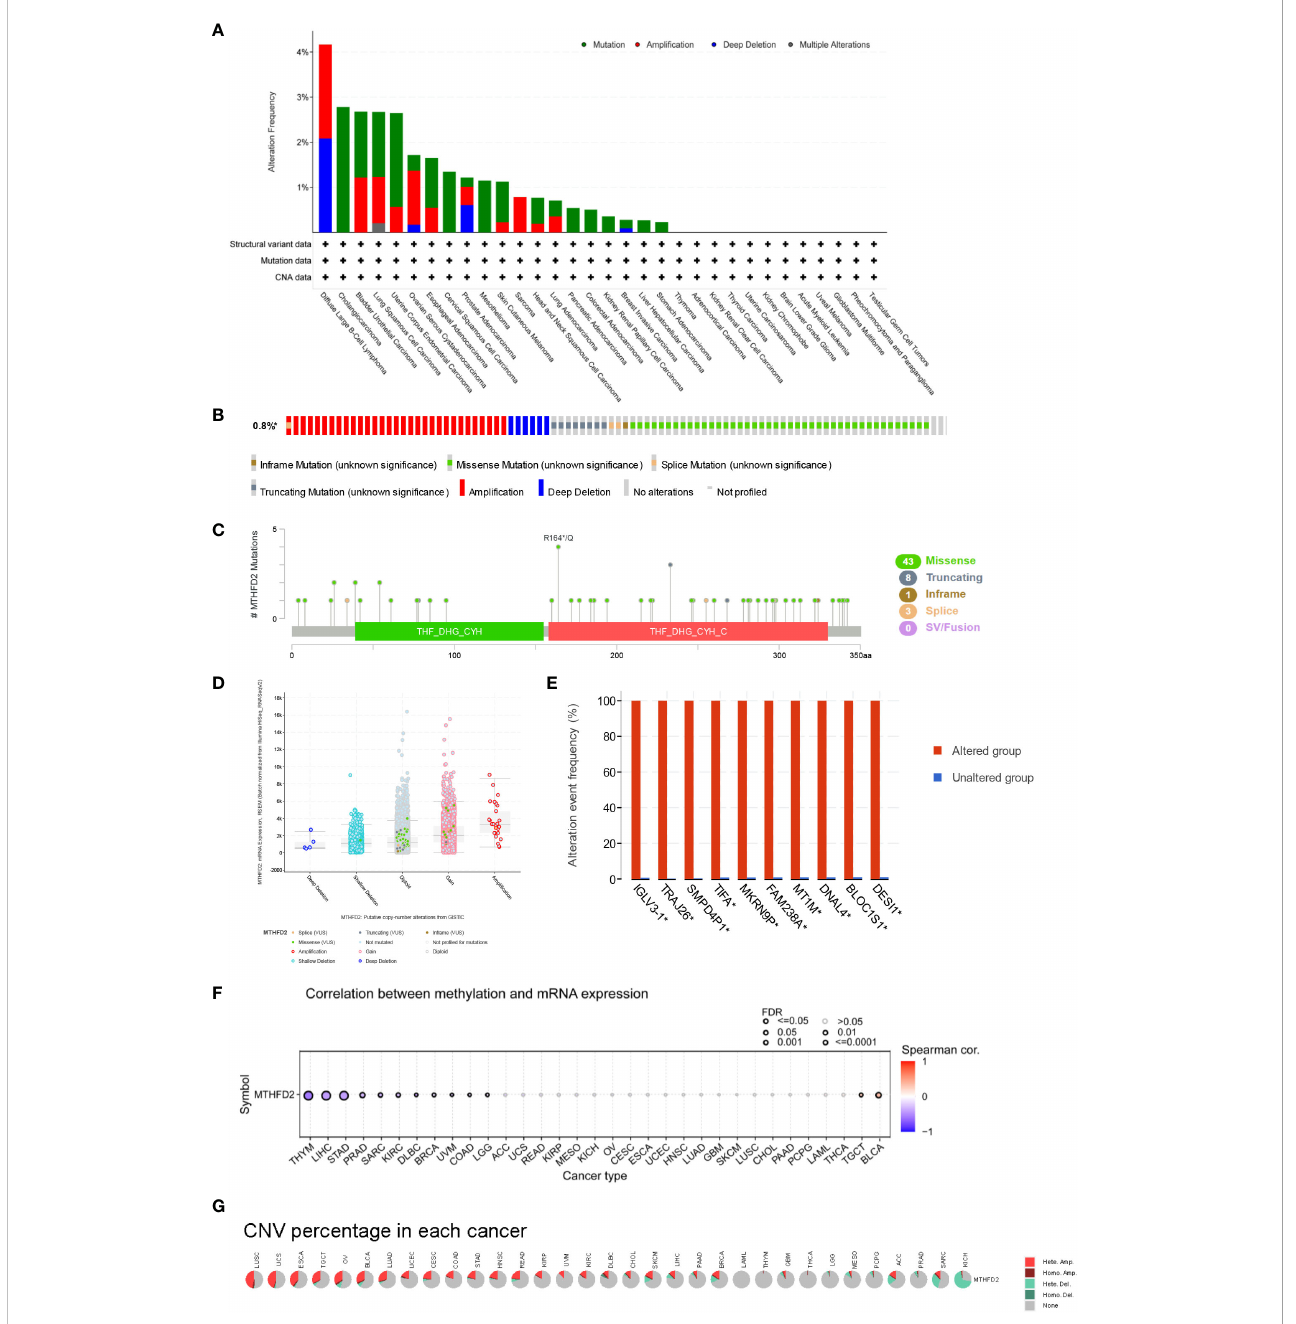
FIGURE 3 Genetic Alteration of MTHFD2. (A) Genetic alterations of MTHFD2 in various tumors. (B) Summary of structural variations, mutations, and copy number alterations of MTHFD2. (C) Summary of mutation types, number, and sites of MTHFD2 gene alterations. (D) Speci fi c change type of MTHFD2. (E) The frequency of top 10 gene variations between the MTHFD2 abnormal and normal groups. (F) Correlation analysis between DNA methylation and MTHFD2 mRNA expression. (G) Assessment of MTHFD2 CNV alterations in